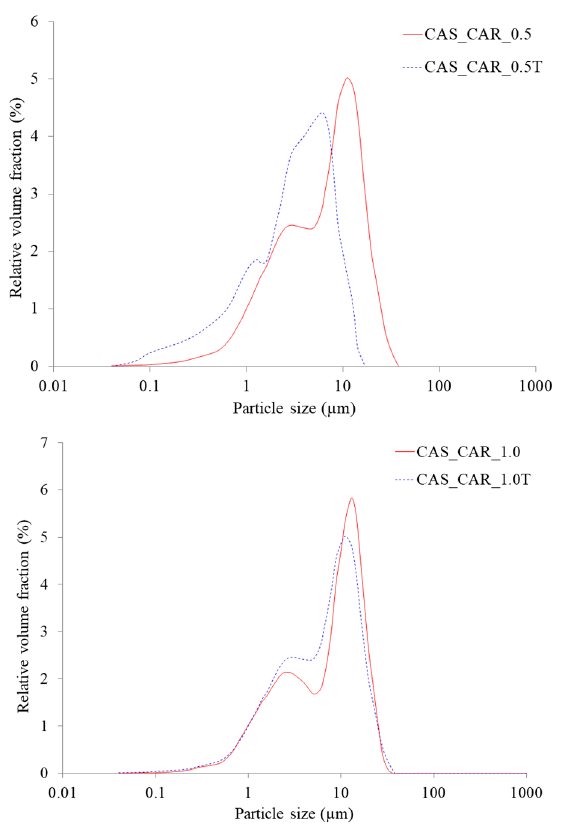
Figure 2. Droplet size distribution of film-forming emulsions containing carnauba wax at 0.5 and 1.0%. Abbreviations: CAS—sodium caseinate, CAR—carnauba wax, T—Tween-80.